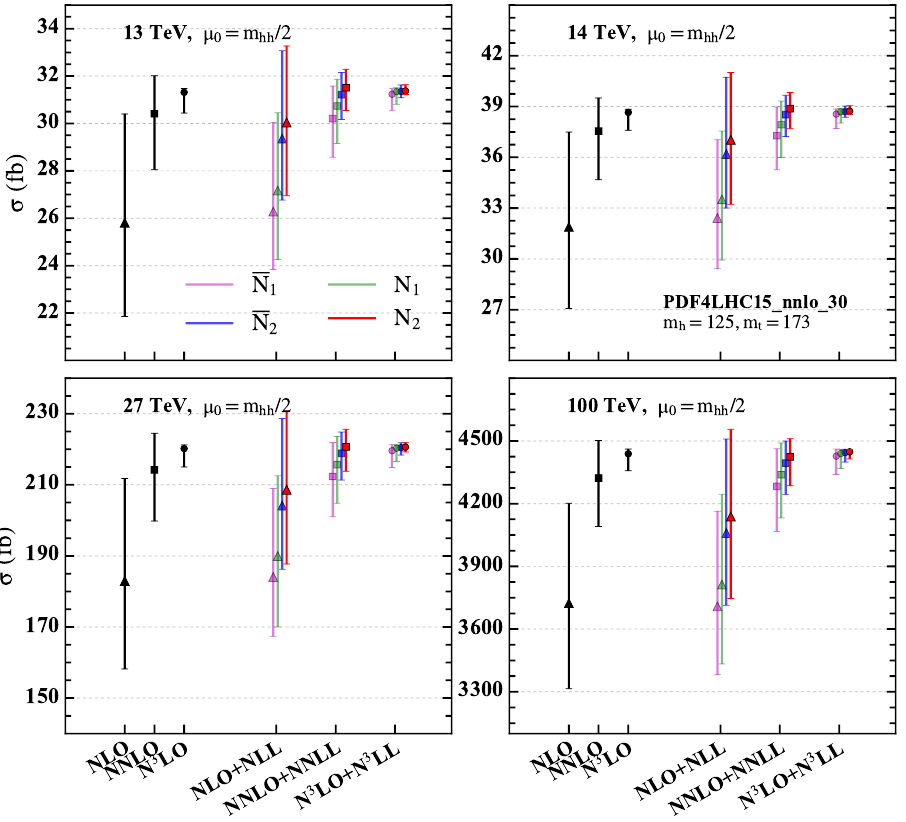
Figure 2 . The comparisons of the inclusive cross sections between the fixed order N k LO calculations (black) and the threshold resummed N k LO+N k LL calculations (coloured) at four different energies √ s = 13 , 14 , 27 , 100 TeV. In each resummation calculation, we have shown four different results stemming from the resummation schemes. They are N (blue) schemes. The error bars are from 7-point scale